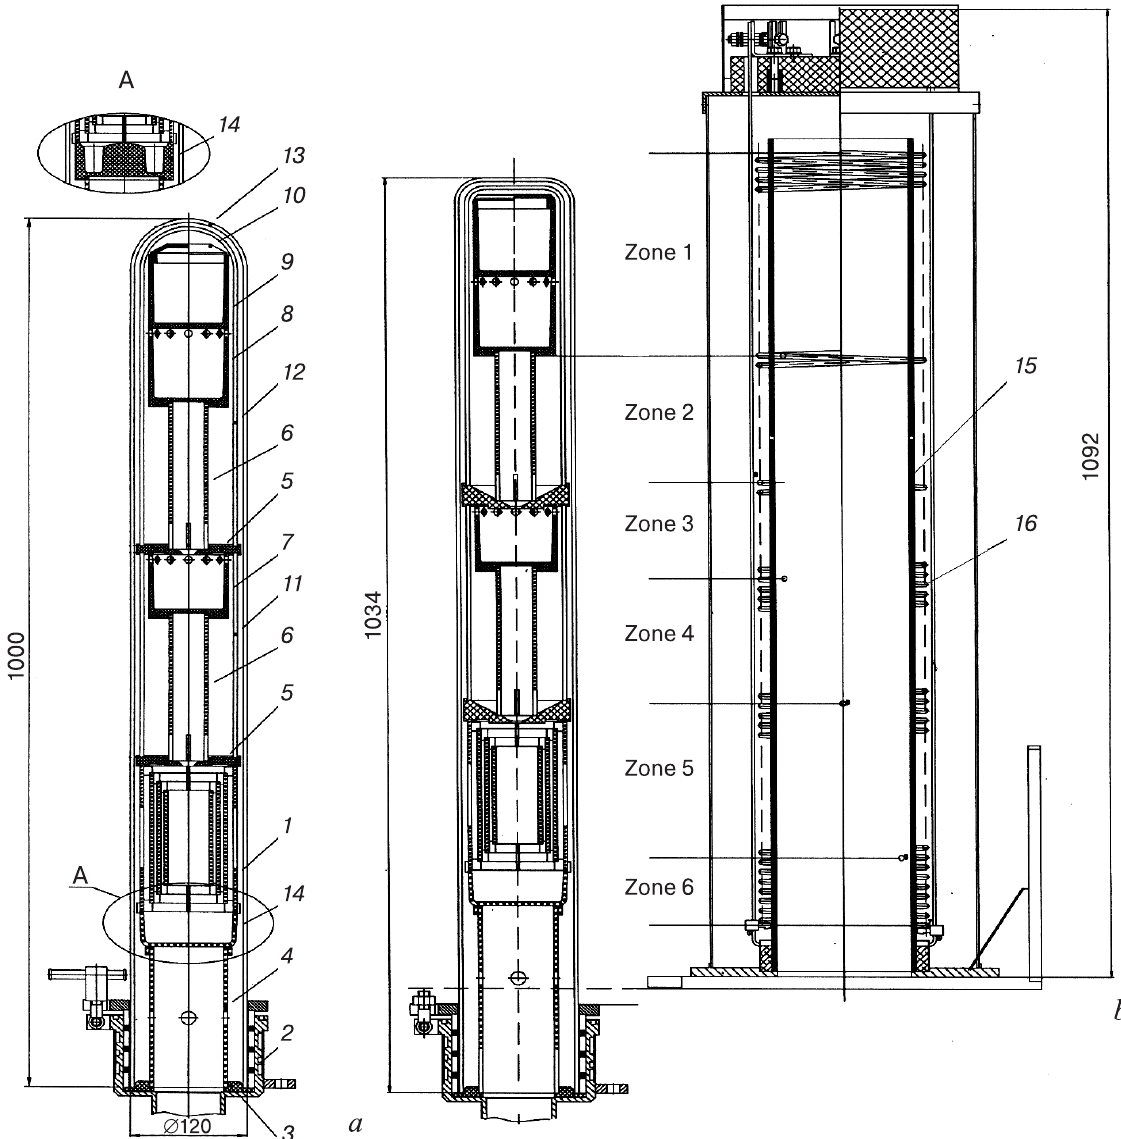
Figure 1. Reactor and fittings: a ) initial design for optimization; b ) upgraded design (left) for simulation and schematic diagram of furnace with heater zones (right) ( 1 condenser; 2 gas and vacuum pipeline flange; 3 fluoroplastic lining; 4 input crucible support; 5 distillation funnel; 6 distillation crucible support; 7 second distillation crucible; 8 first distillation crucible; 9 loading crucible; 10 loading crucible cap; 11 distillation section poles; 12 distillation section flask; 13 quartz flask (reactor); 14 input crucible; 15 co - rundum muffle; 16